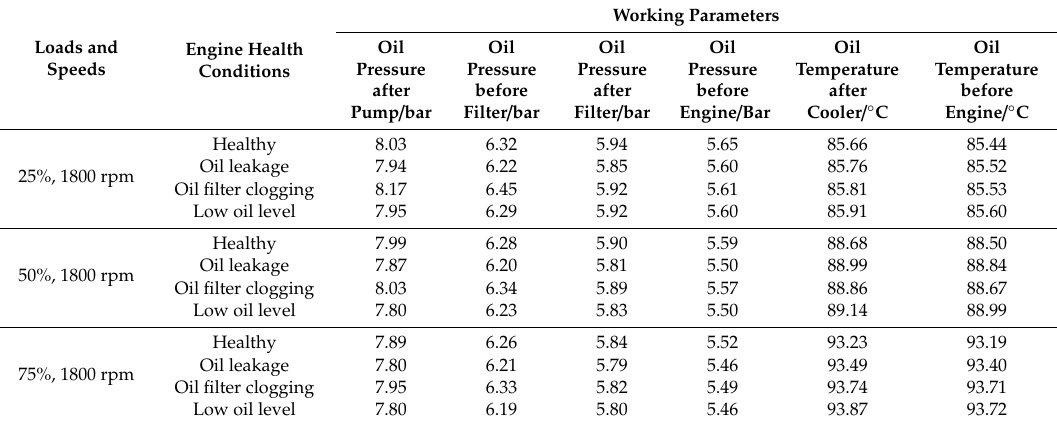
Table 3. Oil pressures and temperatures at di ff erent engine